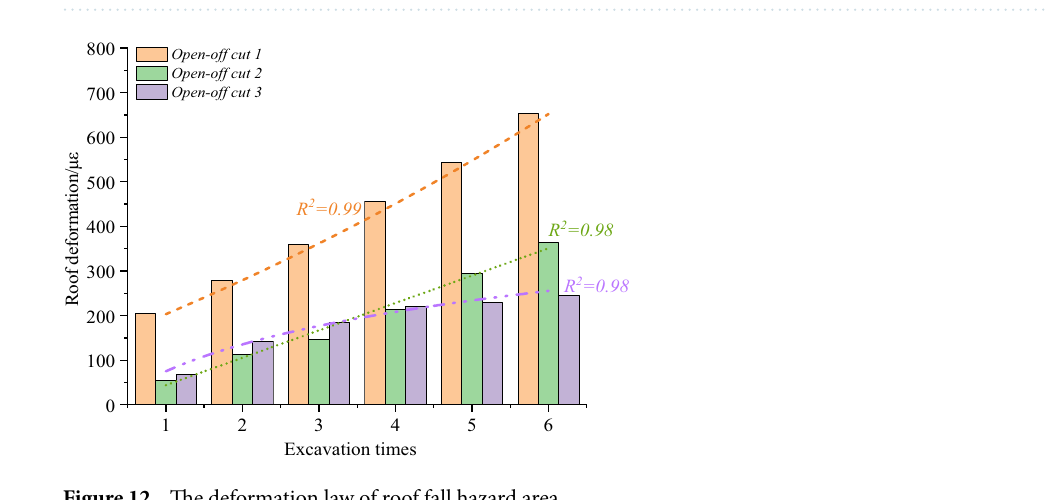
Figure 11. Deformation of open-off cut roof detected by distributed optical fiber.